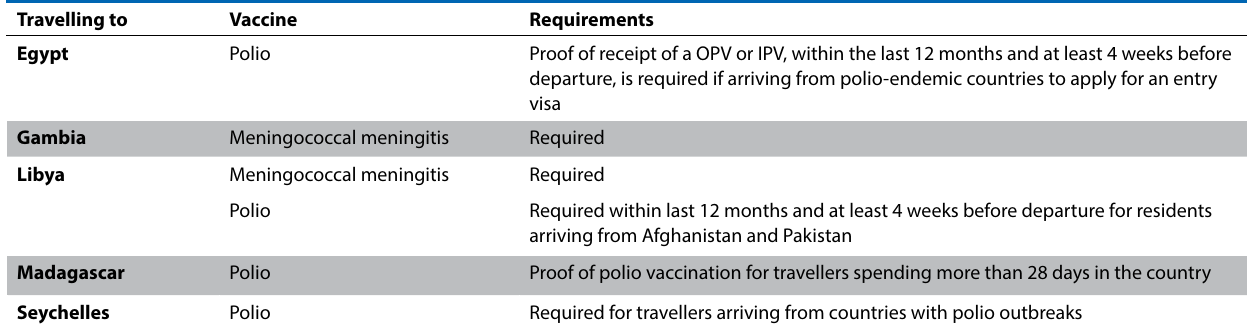
Table 4: Additional vaccine requirements as per country* Travelling